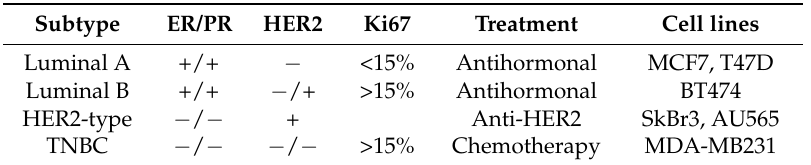
Table 1. Breast cancer molecular subtypes and their main treatments. Representative cell lines for each subtype are also